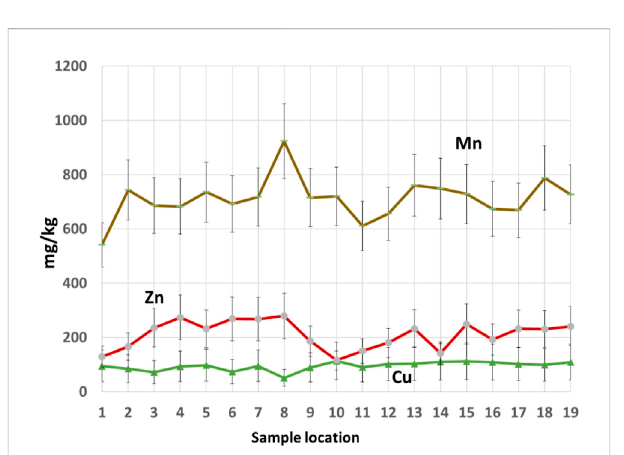
FIGURE 2 Spatial distribution of Mn, Zn, and Cu in dusts collected from the Abu Dhabi-Liwa